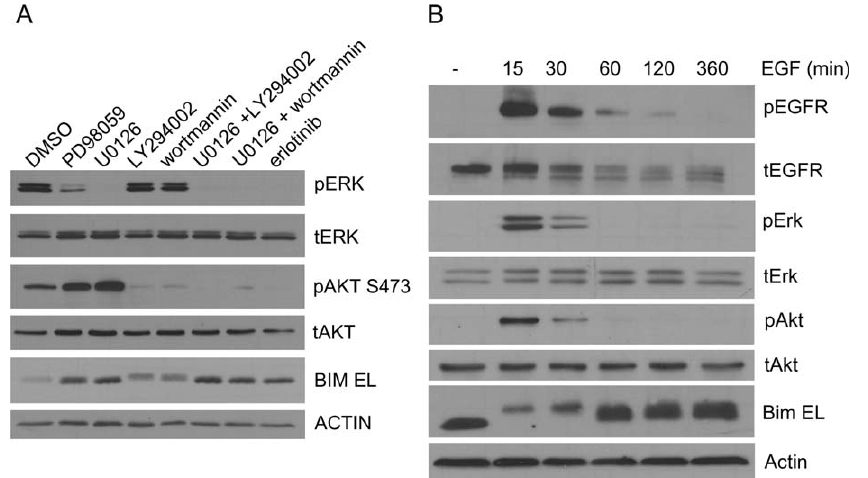
Figure 6. The Status of BIM Is Influenced by EGFR Signaling (A) BIM phosphorylation and protein levels are influenced by the ERK signaling pathway. H3255 cells were treated with a MEK inhibitor (PD98059, 50 l M; U0126, 10 l M), a PI3K inhibitor (LY294002, 50 l M; wortmannin, 100 nM every 2 h), both, or 100 nM erlotinib for 8 h. Cell lysates were analyzed by immunoblotting using the indicated antibodies. (B) NIH 3T3 cells transfected with wild-type EGFR cDNAs were serum-starved overnight and then stimulated with 100 ng/ml human EGF. After the indicated times, cells were harvested. Lysates were analyzed by immunoblotting, using the indicated antibodies. t, total protein; p, phospho-protein.